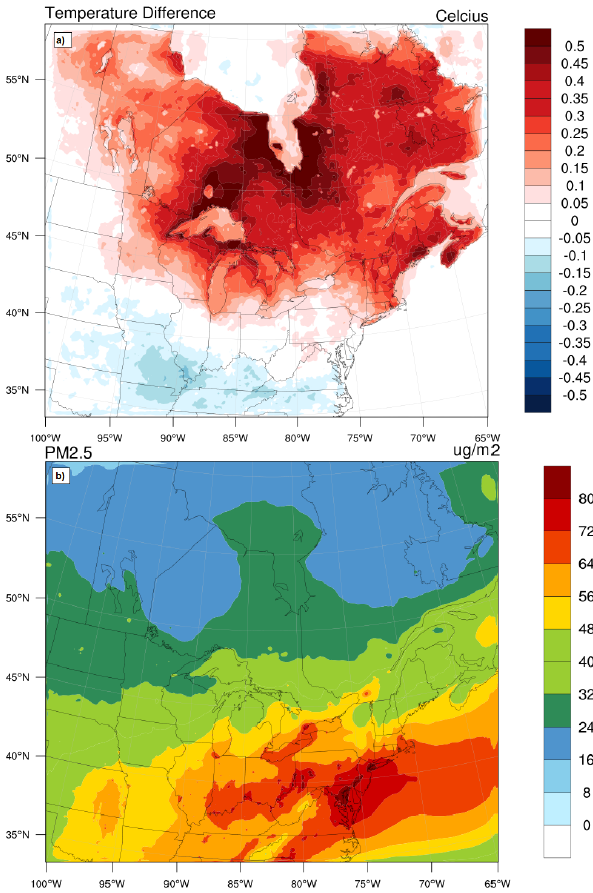
Figure 6. Simulated spatial distributions of: (a) five month mean (April to August 2009) WRF/Chem-WRF Temperature at 2m; (b) WRF/Chem column integrated mass concentration of PM 2 . 5